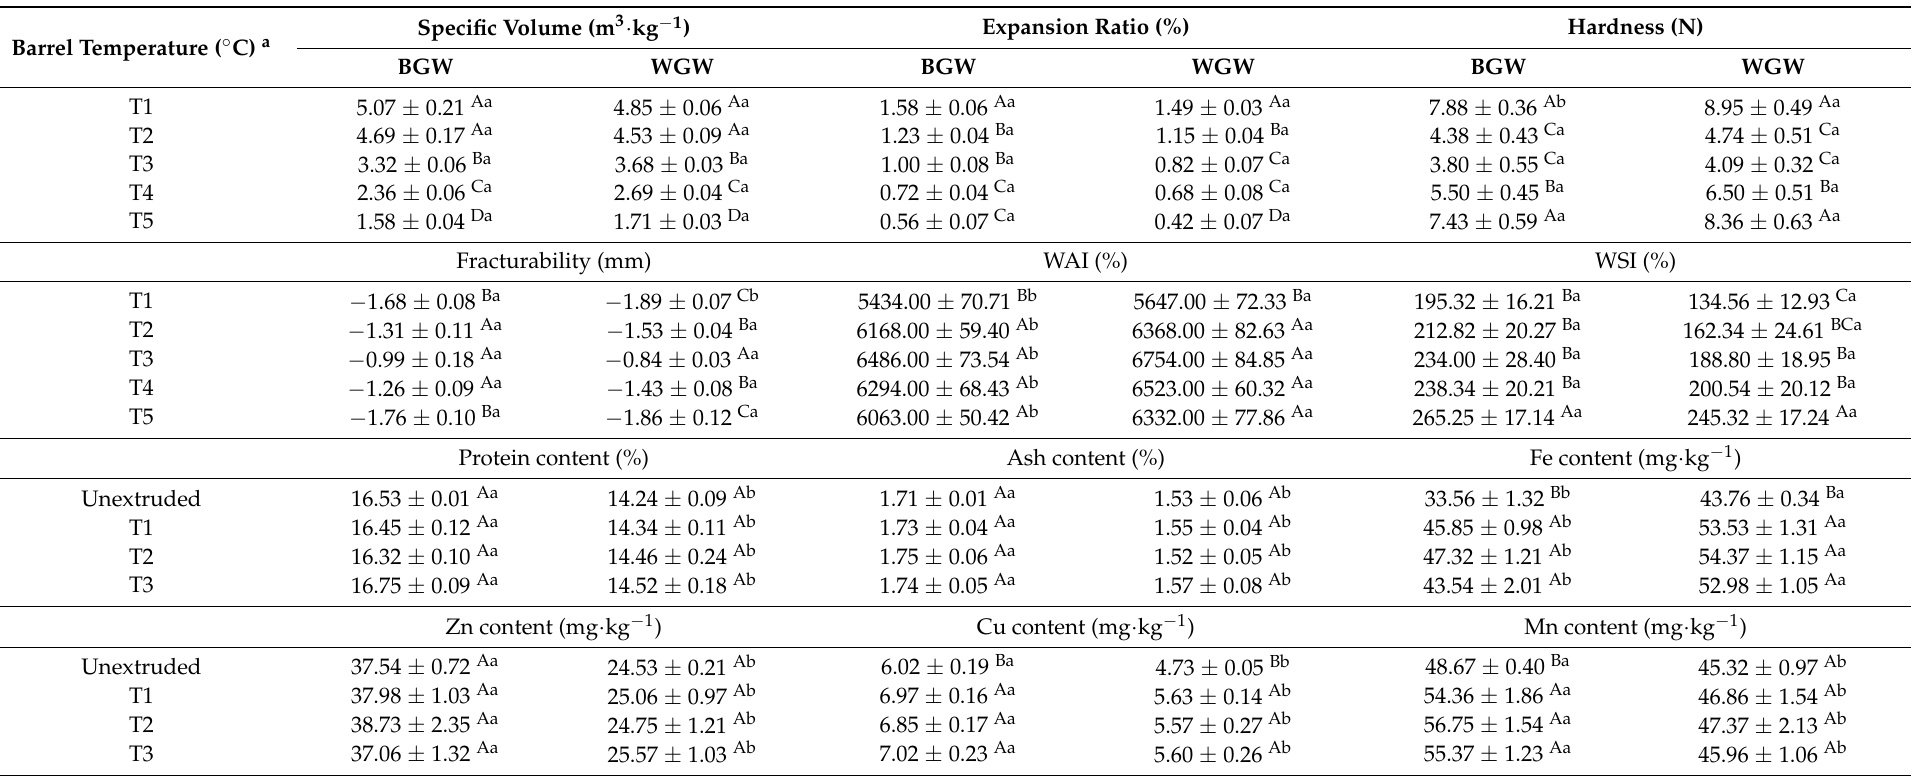
Table 4. Effect of barrel temperature on the physical properties and nutritional components of the wheat